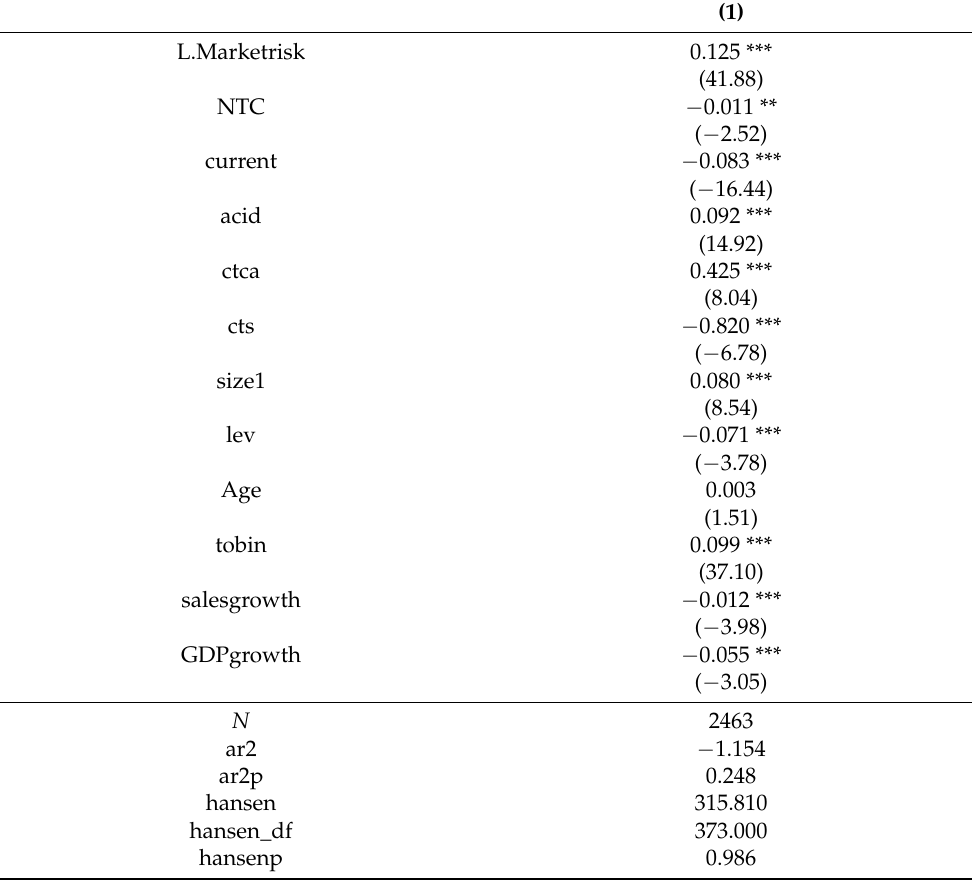
Table 5. Cumulative regression